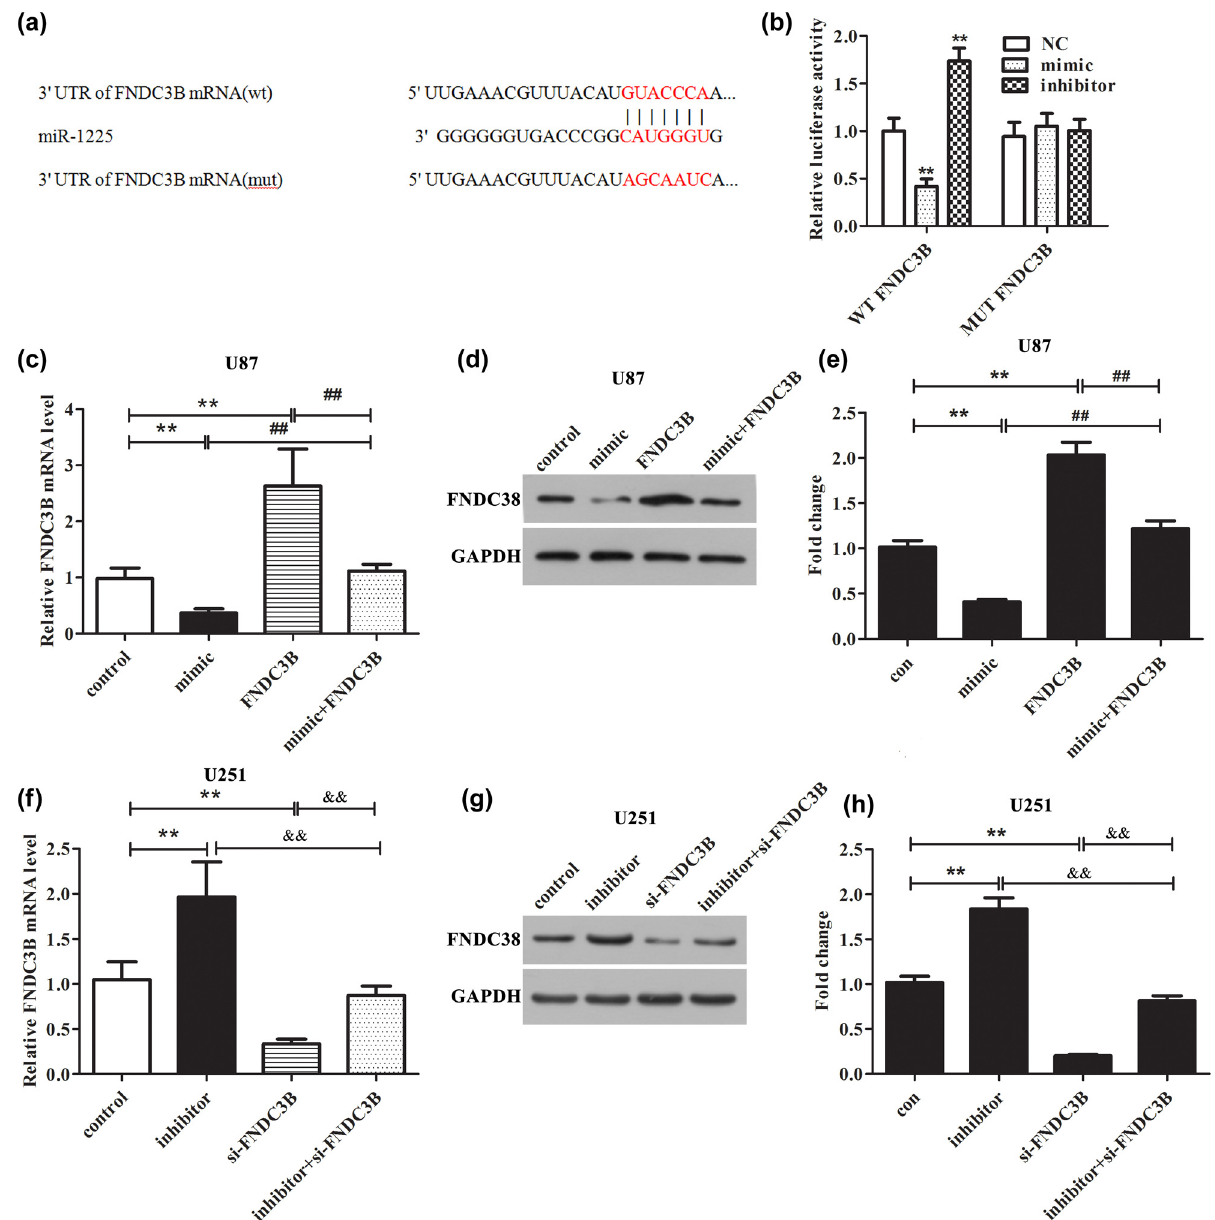
Figure 3: miR - 1225 - 5p directly targets FNDC3B. ( a ) FNDC3B may be the potential target of miR - 1225 - 5p, which was predicted by the miRDB website. ( b ) The luciferase activity assay was carried out to detect the luciferase activity of WT - FNDC3B and MUT - FNDC3B in cells transfected with miR - 1225 - 5p mimic or inhibitor. Then, qRT - PCR and western blot were carried out to assess the mRNA and protein levels of FNDC3B in ( c – e ) U78 and ( f – h ) U251 cells. ** P < 0.01 vs control group. ## P < 0.01 vs miR - 1225 - 5p mimic + pcDNA3.1 - FNDC3B group. && P < 0.01 vs miR - 1225 - 5p inhibitor + si - FNDC3B